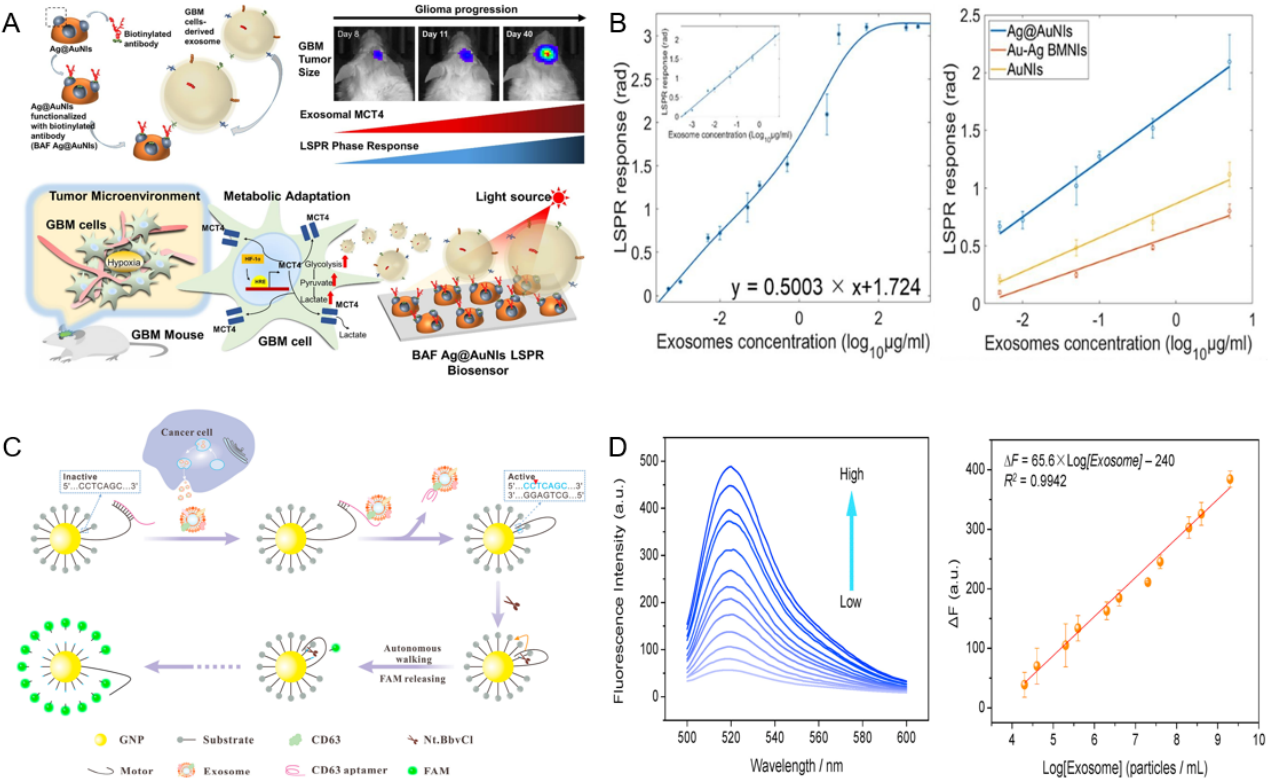
Figure 2. ( A ) Schematic diagram of gold nanoisland − based LSPR biosensor, ( B ) performance evalu- ation of gold nanoisland-based sensor according to exosome concentration versus LSPR response, ( C ) detection strategy of gold nanoparticle DNA motor-based fluorescent sensor, and ( D ) perfor- mance evaluation of fluorescent sensor according to wavelength and exosome concentration. This was reproduced with permission from [49,97], published by Elsevier, 2022 and 2020, respectively.